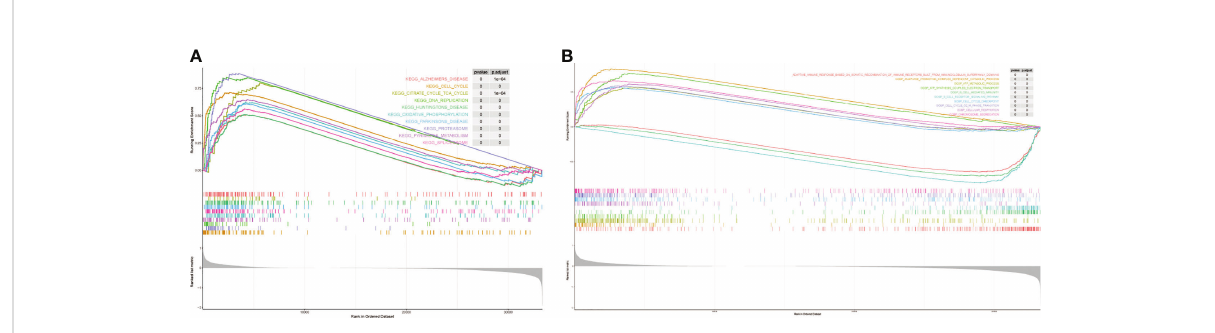
FIGURE 7 The results of gene set enrichment analysis. (A) KEEG enrichment analysis. (B) GO enrichment analysis.